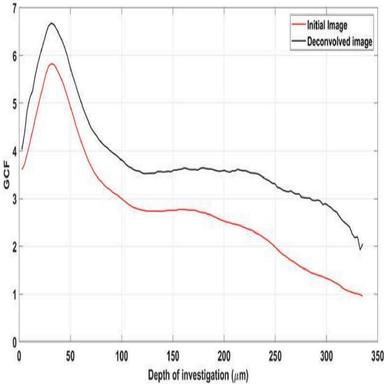
Computed GCF depth profile of the initial 3D confocal image of an etched epoxy pore cast of IL (red), and the deconvolved image based on the depthdependent PSF function to correct for spherical aberration (black). Higher GCF values for the deconvolved image indicate better image quality. The image was captured using a 10X air objective, thus significant spherical aberrations are expected as nepoxy = 1.55 and nair = 1.